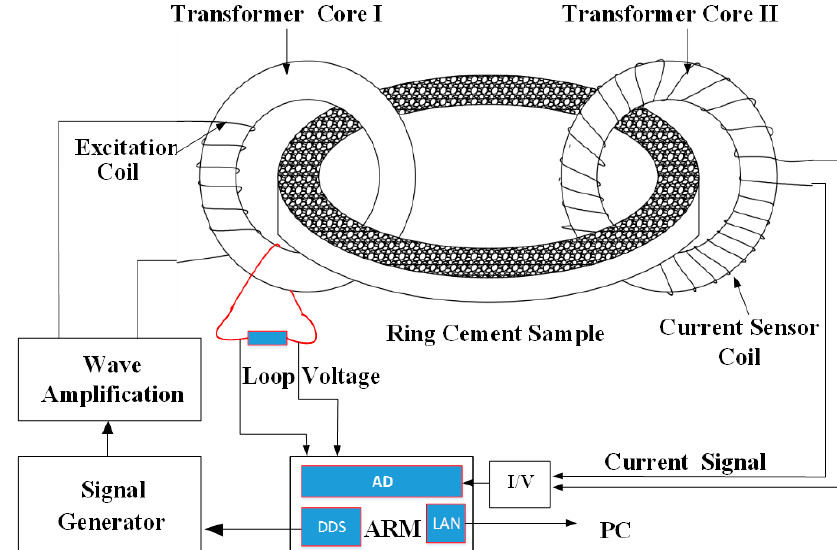
Figure 1. The schematic illustration of NCACII.